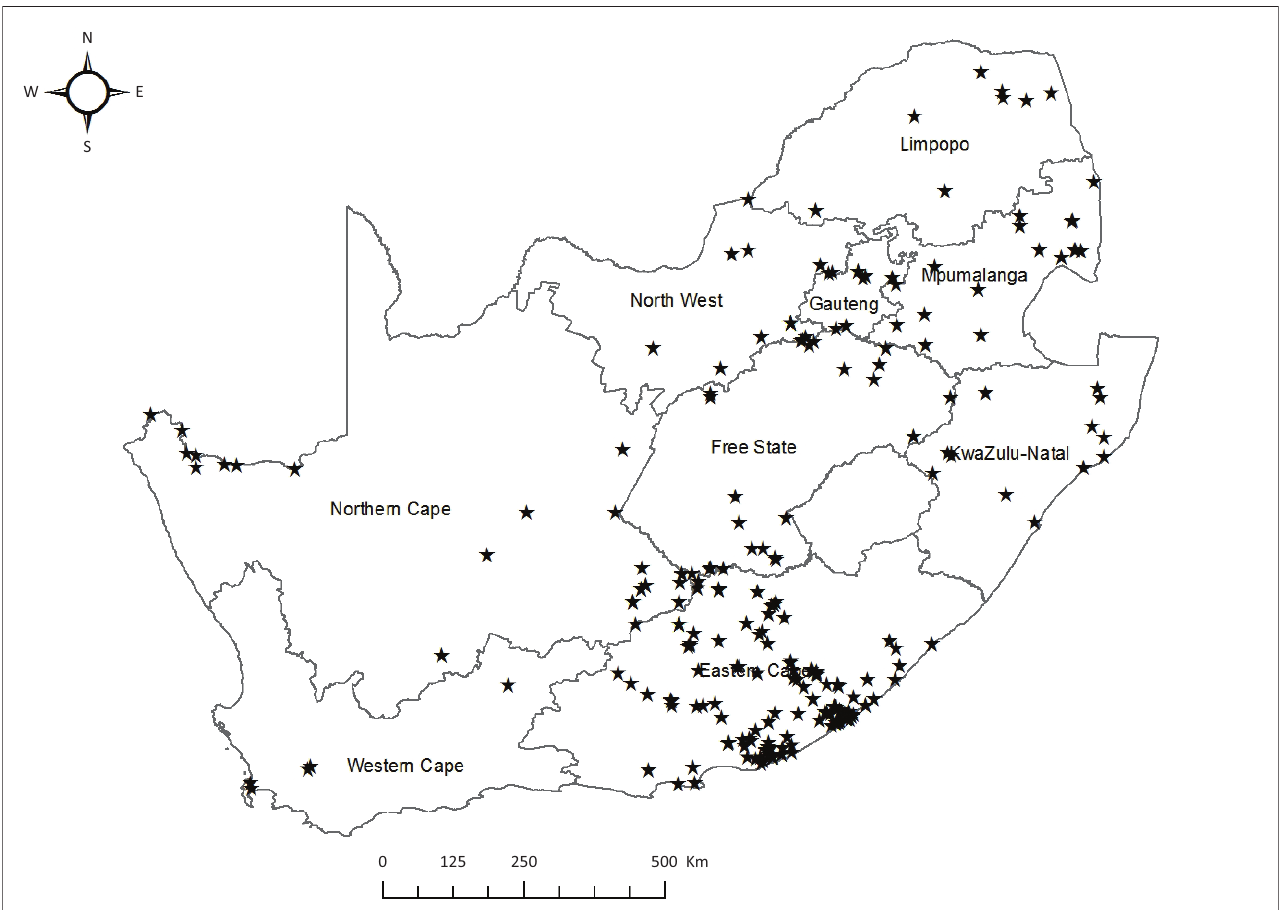
FIGURE 5: Integrated distribution map of Unio caffer in South Africa based on occurrence records from all the above sources (Figures 1–3). The black stars represent U. caffer localities.